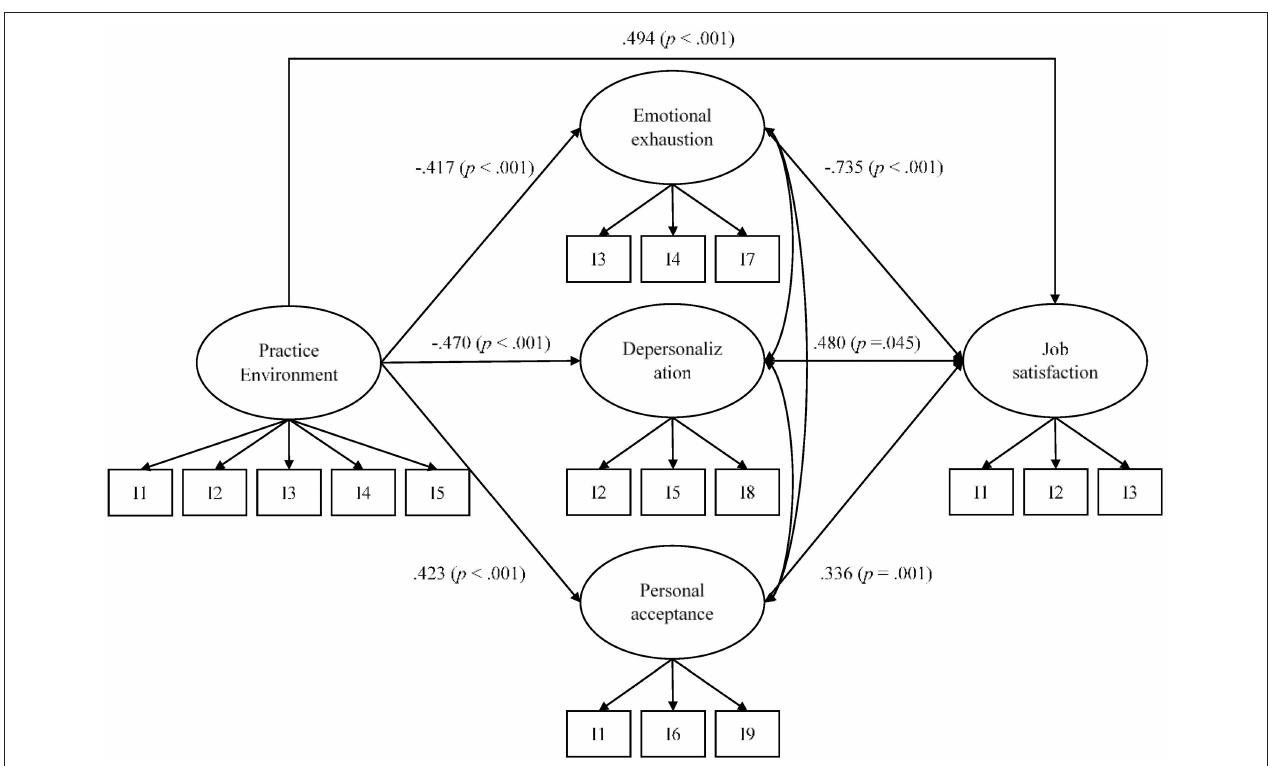
FIGURE 1 | Results of the predictive model with the BNPE scale. For the sake of clarity, only predictive relations are shown. All factor loadings were statistically significant ( p < 0.001). Correlations among the burnout dimensions were: 0.768 ( p < 0.001) between emotional exhaustion and depersonalization; − 0.315 ( p < 0.001) between emotional exhaustion and personal acceptance; and − 0.486 ( p < 0.001) between depersonalization and personal acceptance.